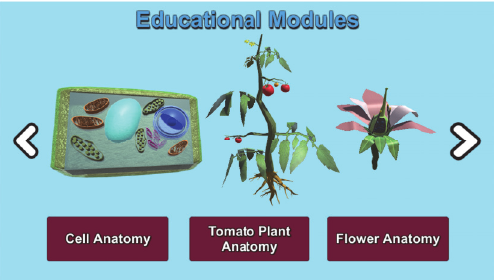
Figure 22: Plant structures-selection scene.